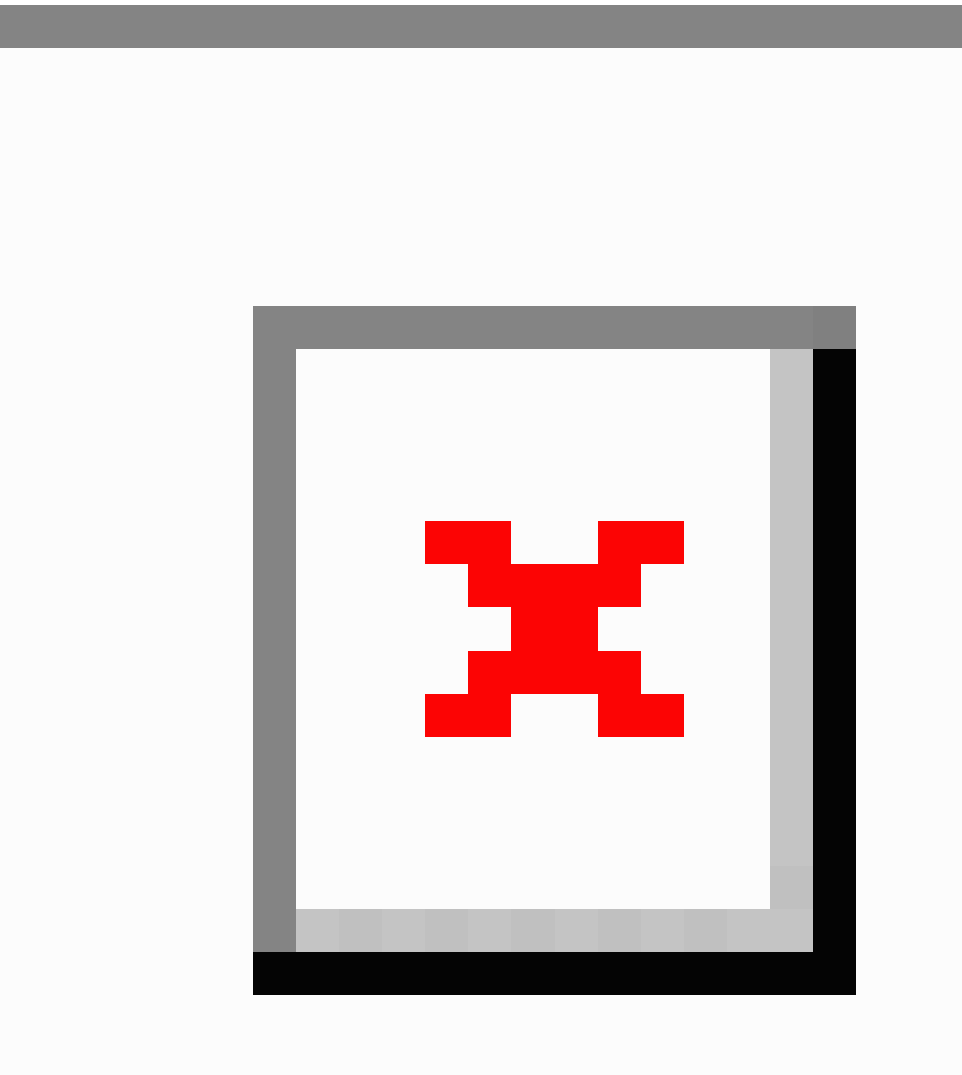
Figure 2. Percentage of participants who followed the recommendation to start with the correct number of intervention modules differentiated by education, income, work, age, gender, and disease status. Age was categorized as 1=young and 2=old based on a mean split of 44 years. * P <.05, ** P